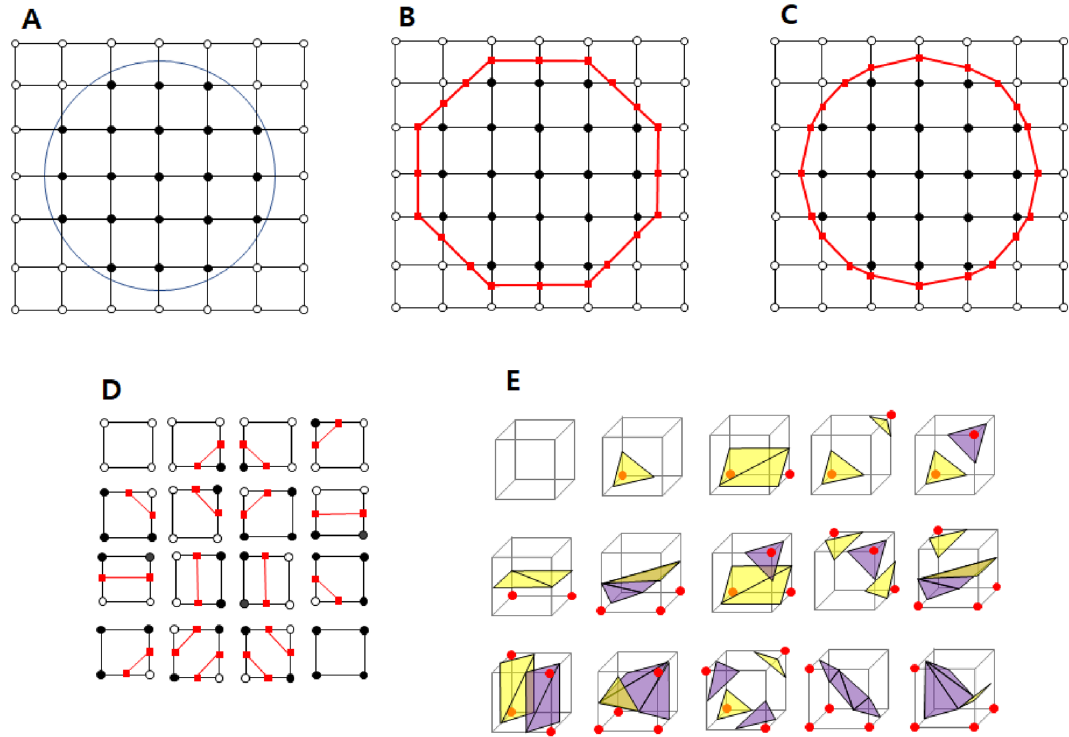
Figure 7. Marching cube algorithm. ( A ) The algorithm divides the space into uniform cell units and divides the cells in and out of the circle. ( B ) Boundary making matching the dictionary of 16 possible cases. ( C ) Distance from the center to the edge is approximated to the actual distance. ( D ) All 16 2D marching cube combinations used to make the boundary. ( E ) All 15 3D marching cube combinations used to make the